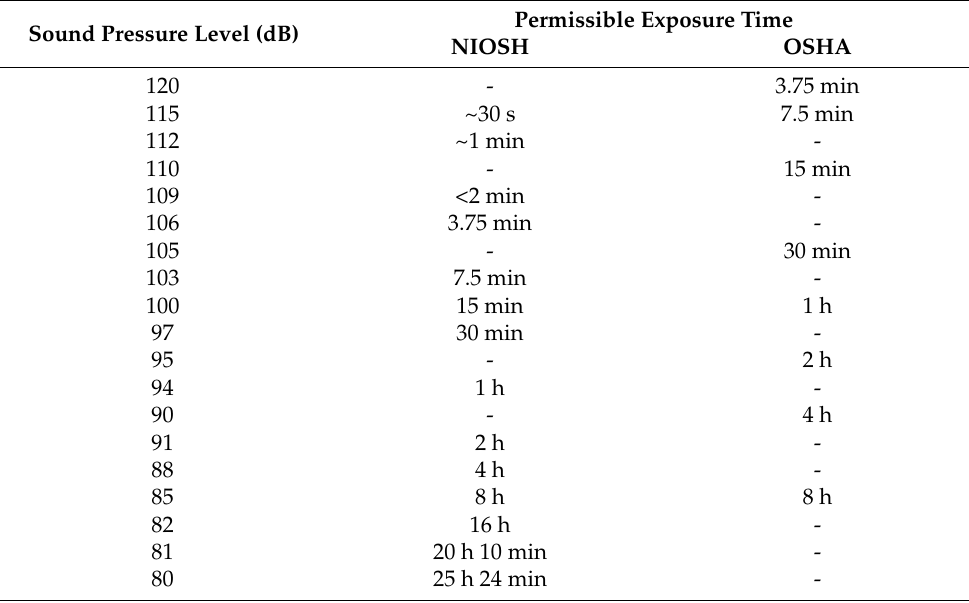
Table 1. Occupational noise exposure limits recommended by NIOSH and OSHA. Sound Pressure Level (dB)